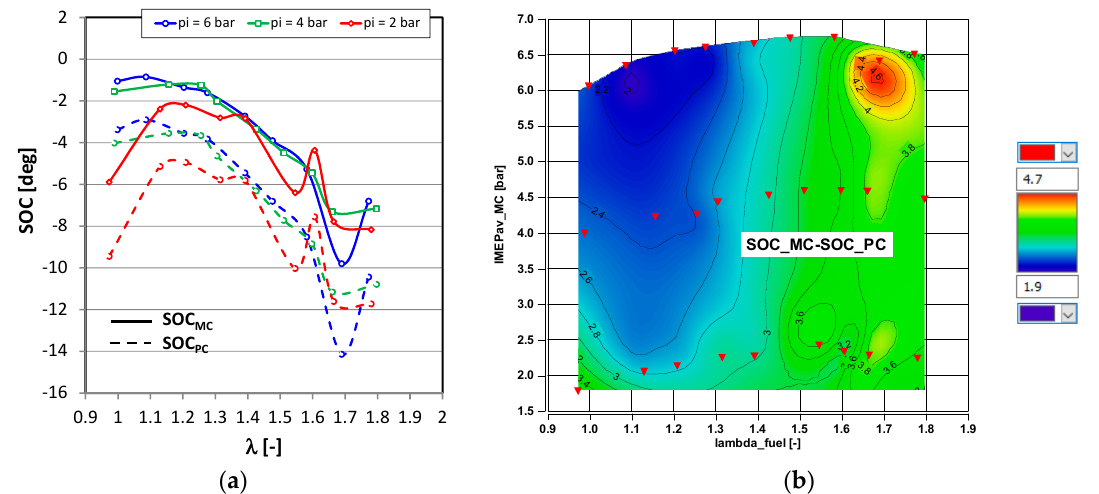
Figure 16. Changes in the start of combustion (SOC) due to engine load and mixture composition: ( a ) SOC changes in both chambers; ( b ) a map of the differences in the ignition start in the prechamber and the main chamber.